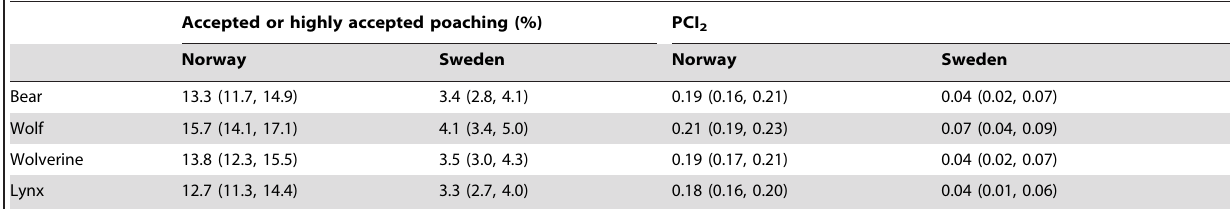
Table 4. Mean (95% confidence interval) percentage of respondents who agreed or highly agreed that poaching was acceptable (binomial distribution), and mean (95% confidence interval) potential conflict index (PCI 2 ) at county level for each carnivore species.